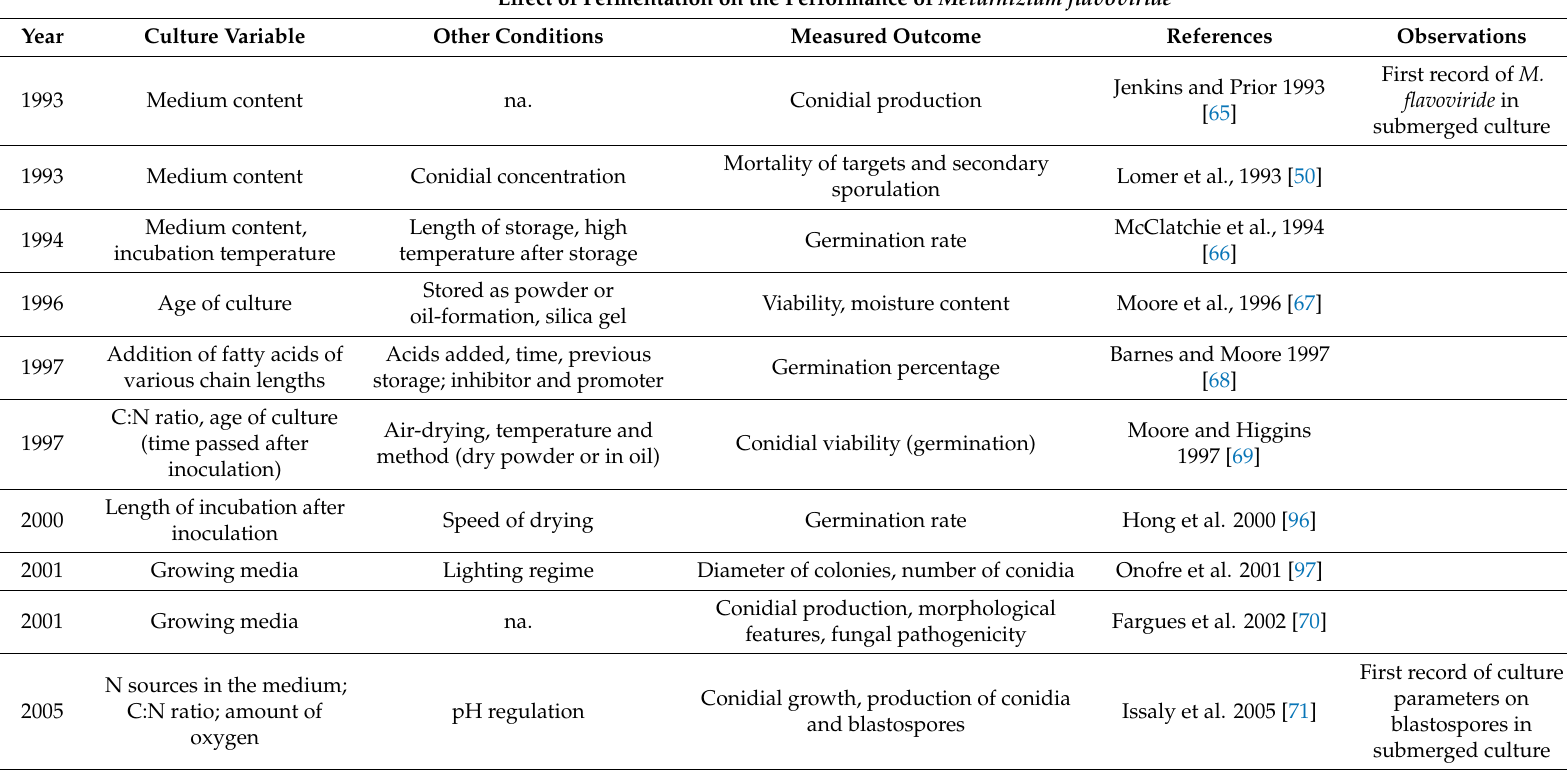
Table 2. The e ff ect of fermentation, formulation and the e ffi cacy of Metarhizium flavoviride sensu lato under greenhouse and open field conditions. We selected studies that provide suggestions for the application of M. flavoviride s. lato against arthropod pests. Note that before the general spread of rDNA sequence data-based examination (i.e., before 2000) species identification used to rely on conidial shape and size, so earlier publications using acridid pests as target species may